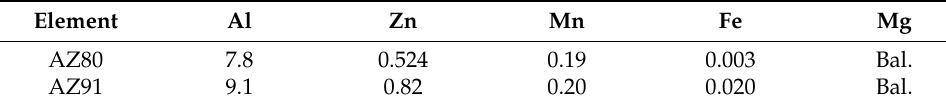
Table 1. Chemical composition (mass%) of AZ80 and AZ91 alloy. Element